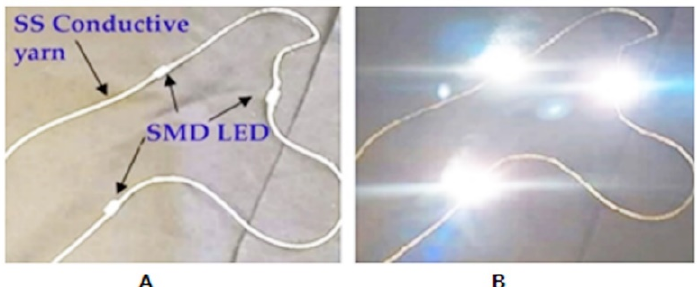
Figure 12. Actual prototype of LEDs integrated into a stainless steel yarn ( A ) and lit E-yarn ( B ).